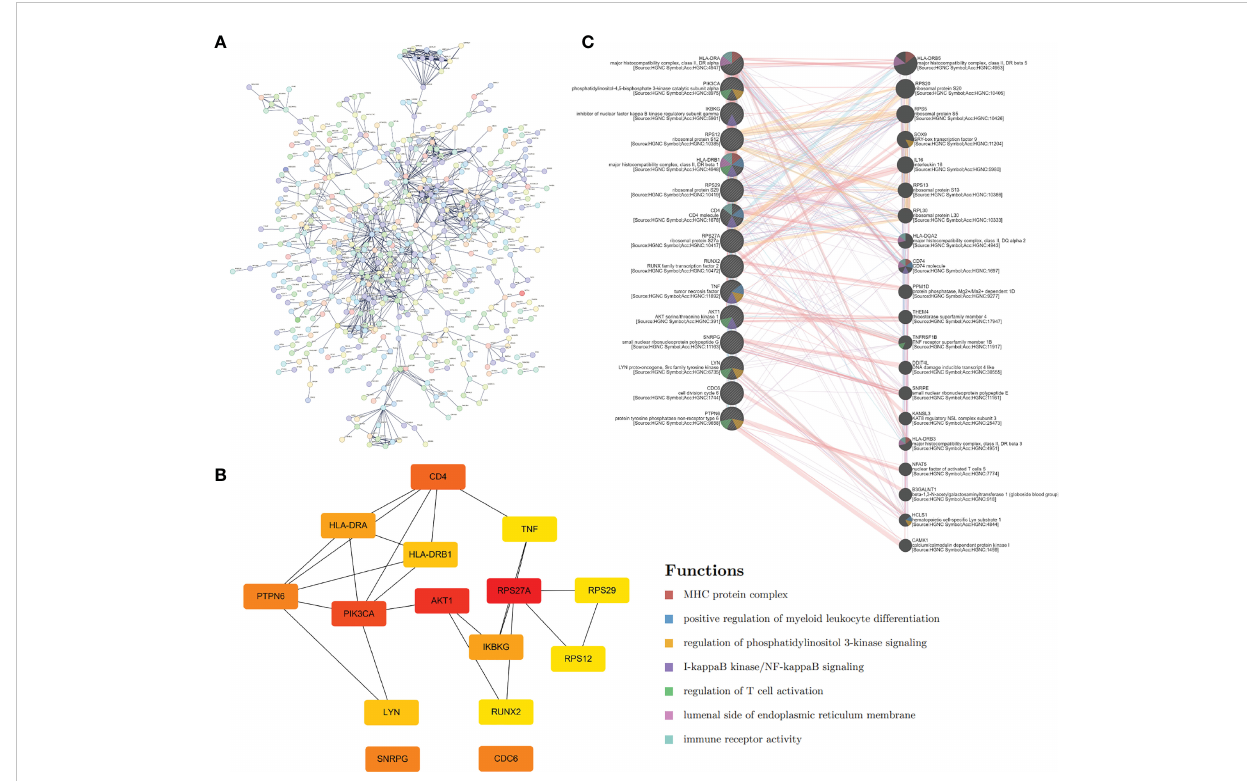
FIGURE 2 Hub genes extraction and PPI network construction. (A) PPI network of Tex-related genes constructed by STRING. (B) The top 15 hub genes and their relationship were calculated and visualized by Cytoscape. (C) GeneMANIA database helps predict the hub gene interaction network based on gene correlations such as colocalization, coexpression, and shared protein domains. The 15 hub genes were listed on the left side, and the top 20 mostly related neighboring genes are shown on the right